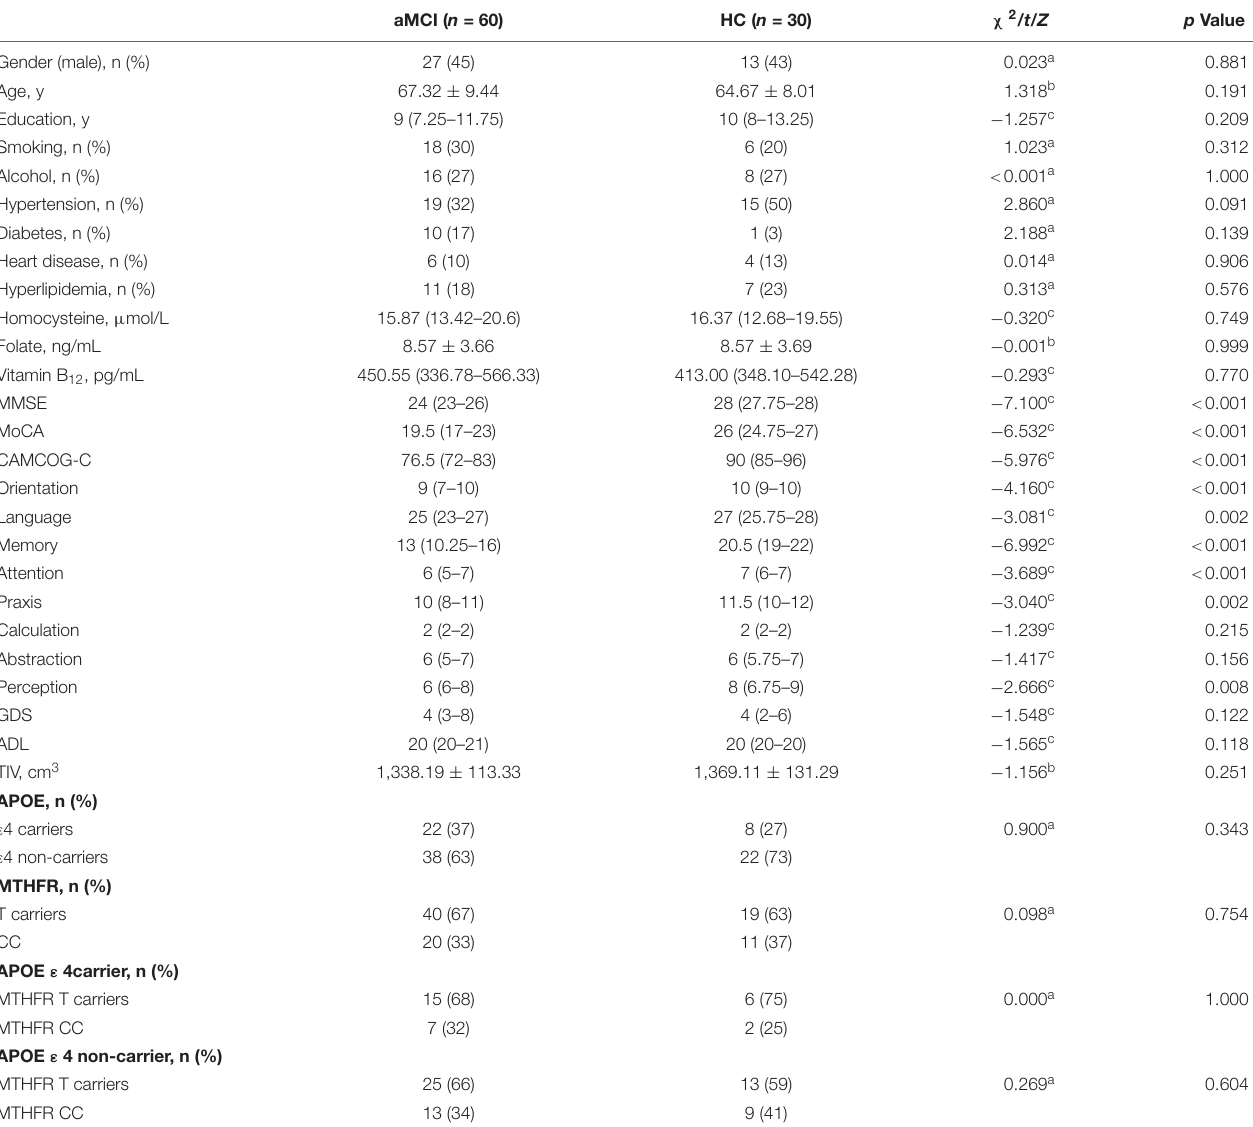
TABLE 1 | Comparison of demographic, clinical, genotype, and neuropsychological characteristics between the amnestic mild cognitive impairment (aMCI) group and the healthy control (HC) group. aMCI ( n = 60) HC ( n = 30) χ 2